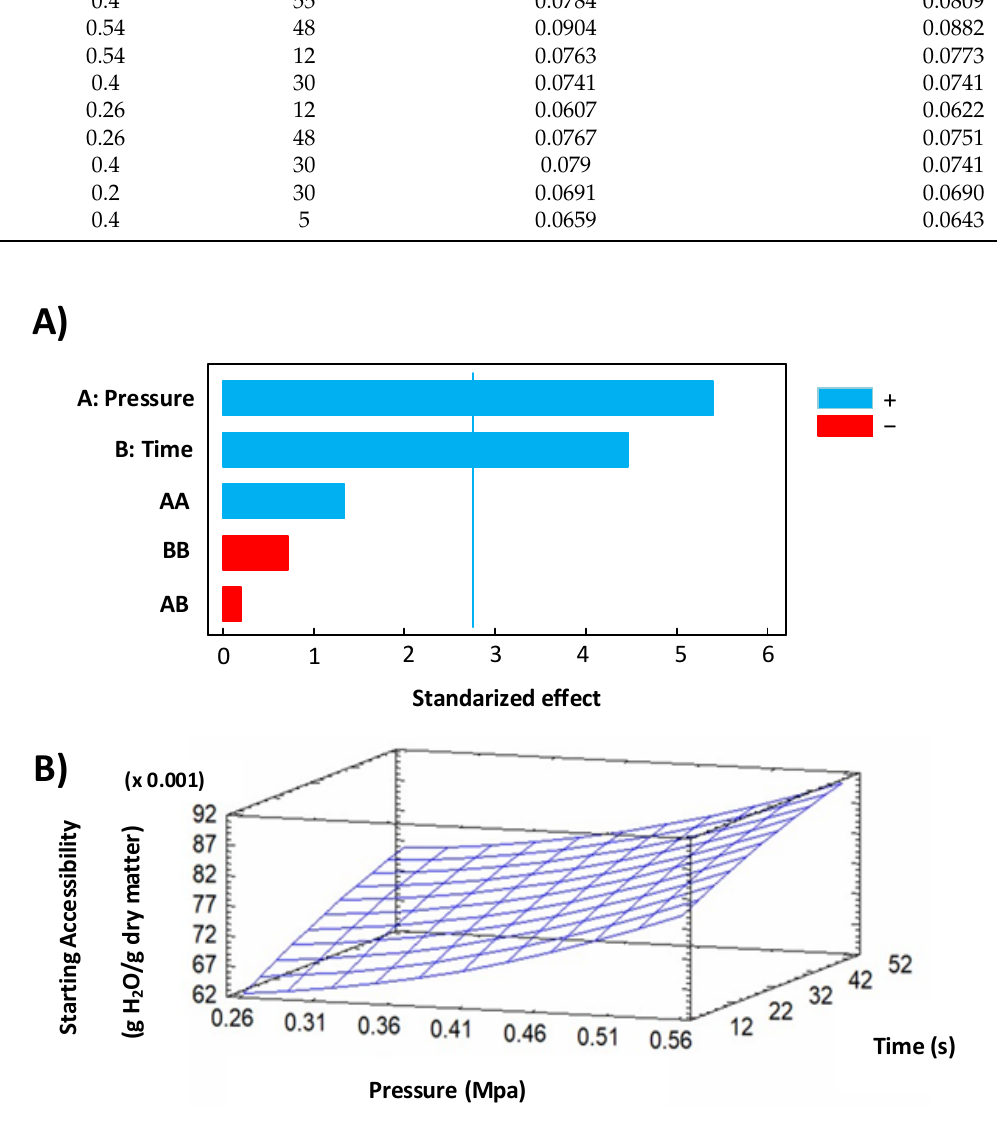
Figure 8. Effect of DIC treatment on starting accessibility: ( A ) Pareto chart and ( B ) response surface graph.